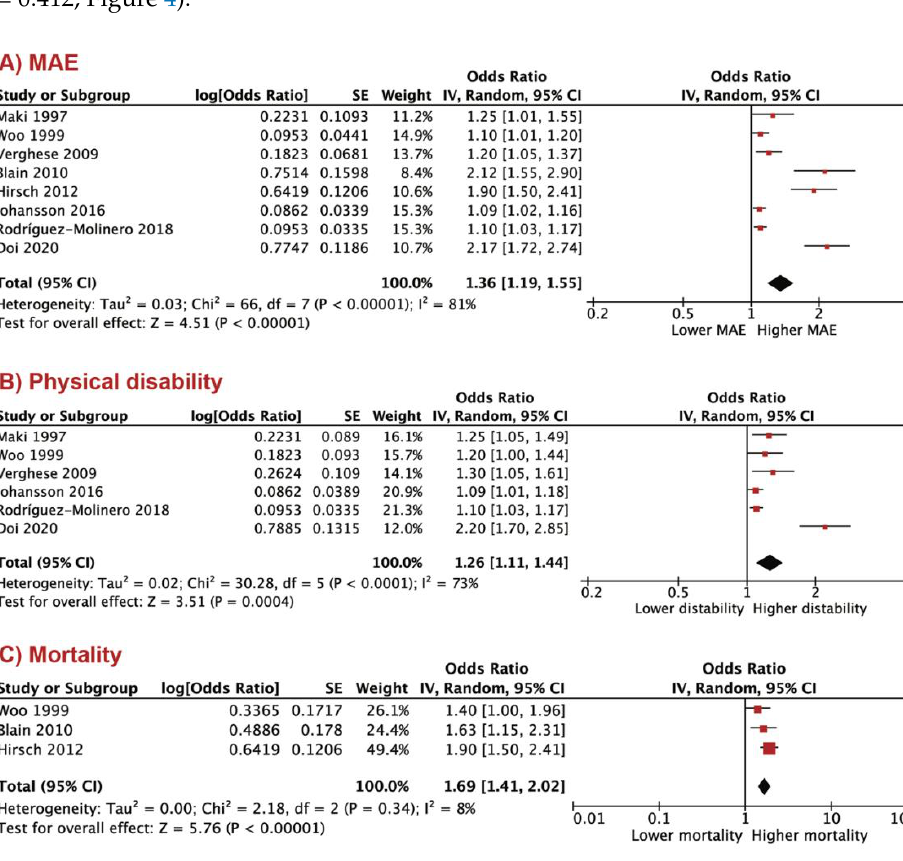
stride velocity; ( E ) step width.